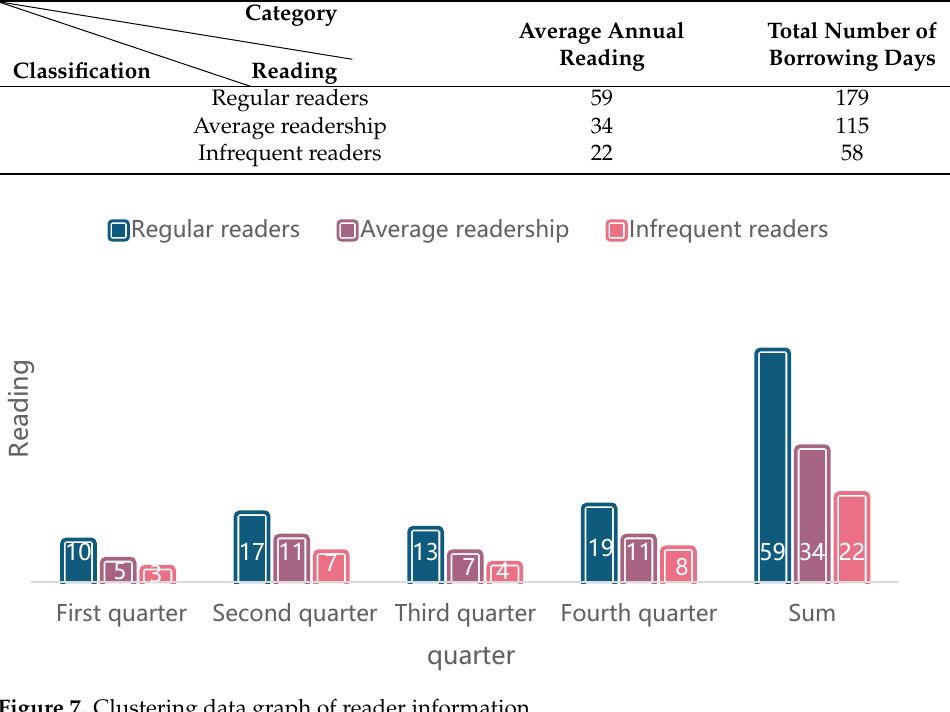
Figure 7. Clustering data graph of reader information.